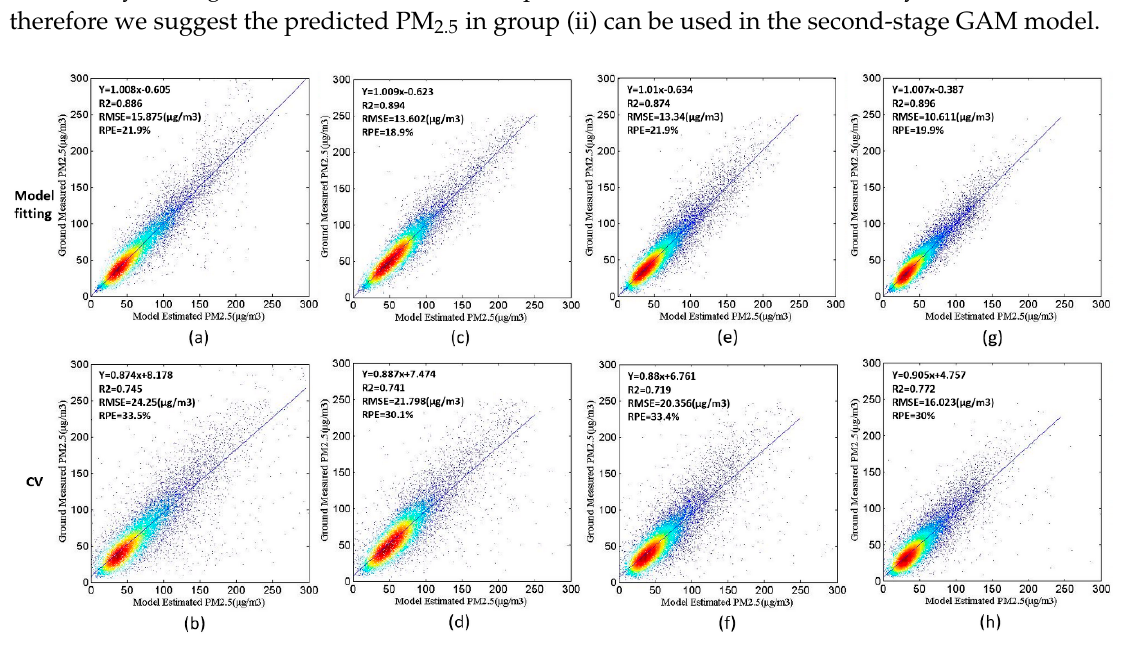
Figure 5. The accuracy evaluation of the second-stage GAM model on groups (i)+(ii). (a) and (b): 2013; (c) and (d): 2014; (e) and (f): 2015; and (g) and (h): 2016. The red lines are regression lines.